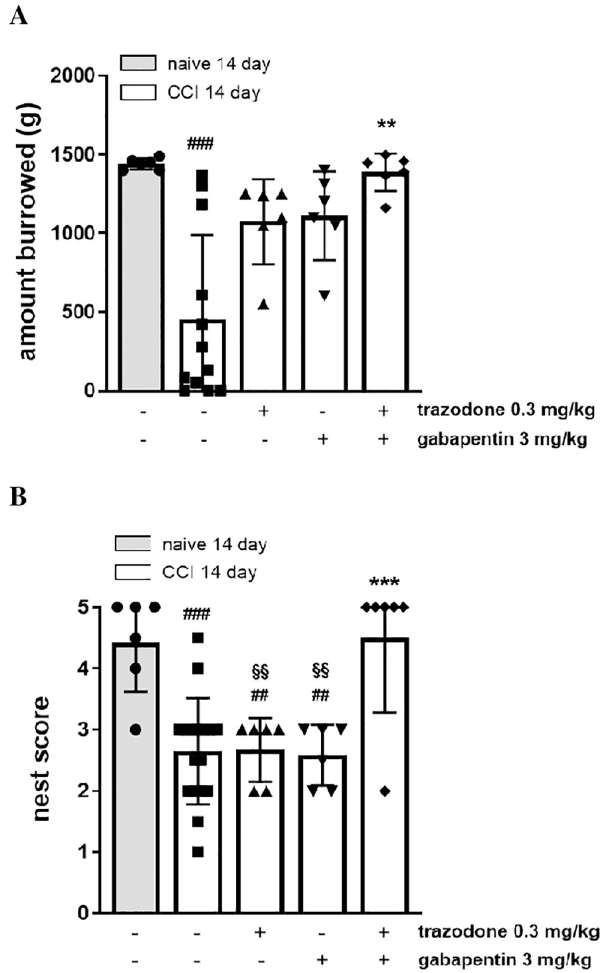
Fig 4. Effect of two ineffective doses of trazodone and gabapentin alone or in combination on the burrowing test (A) and the nest construction (B) 14 days following rat sciatic nerve ligation. The results are expressed as the amount of gravel displaced by burrowing and nest-building scores calculated 1 h after treatment administration. ##P < 0.1, ###P < 0.001 vs na ï ve group; �� P < 0.01, ��� P < 0.001 vs vehicle CCI group; §§P < 0.01 vs trazodone- gabapentin CCI group. n = 6–12